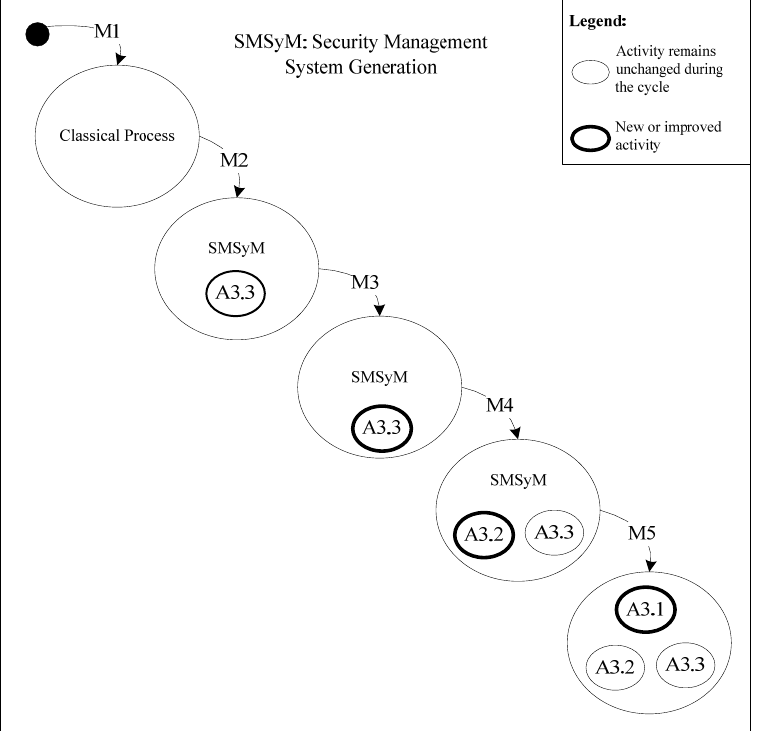
Figure 5. The use of AR to obtain the SMSyM processes.